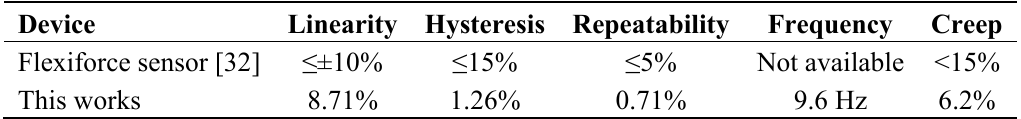
Table 1. Comparisons with a commercial